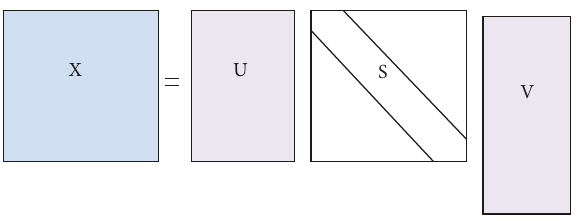
Figure 1: Matrix X after SVD